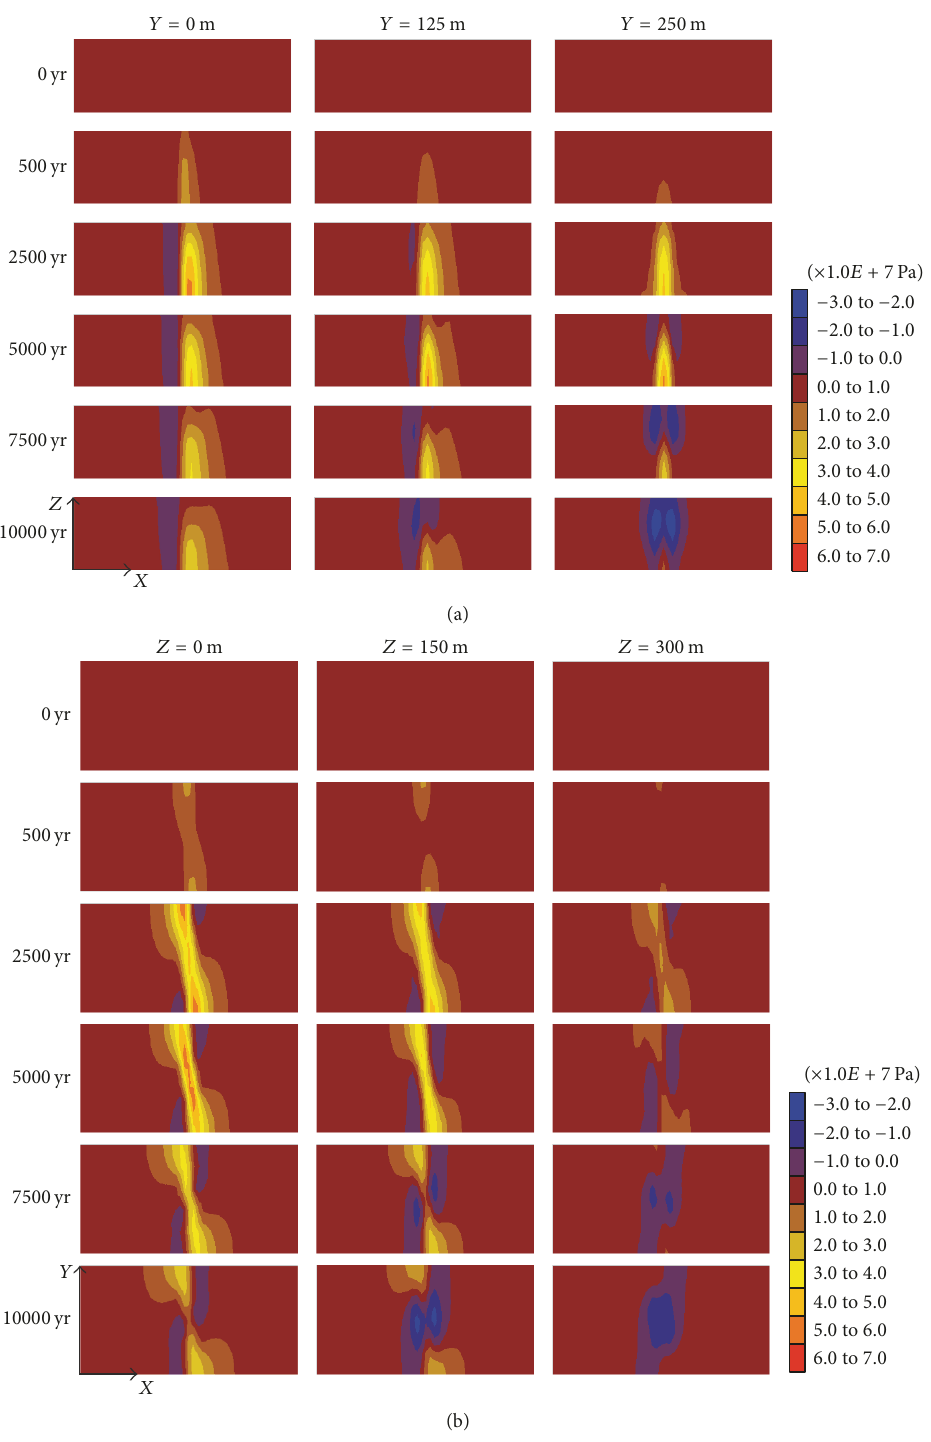
Figure 4: Contour map of the pore pressure ( 𝑃 ) for Model I at different times. (a) is three vertical cross sections of 𝑌 = 0 , 125 m, and 250 m; (b) is three horizontal cross sections of 𝑍 = 0 , 150m, and 300